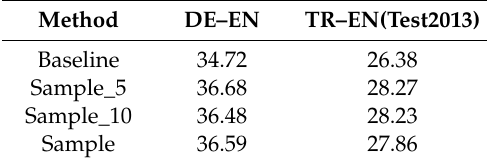
Table 8. Performance of decoding with the di ff erent sampling